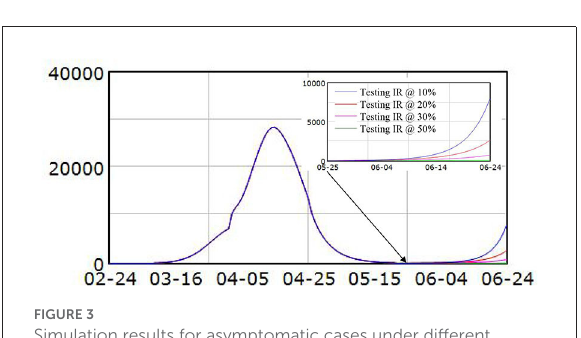
2,600 and 770, respectively. When the identification rate remained at 50%, the asymptomatic cases would be < 100.